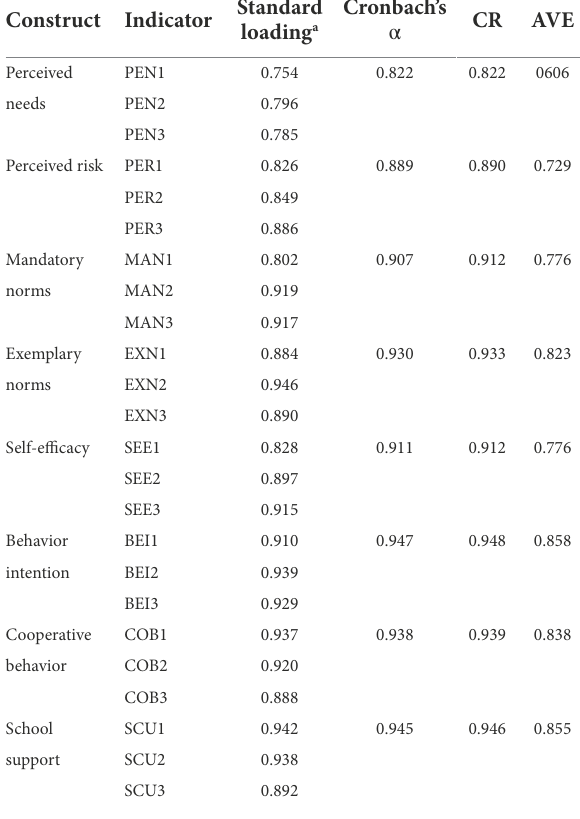
TABLE 2 Results of confirmatory factor